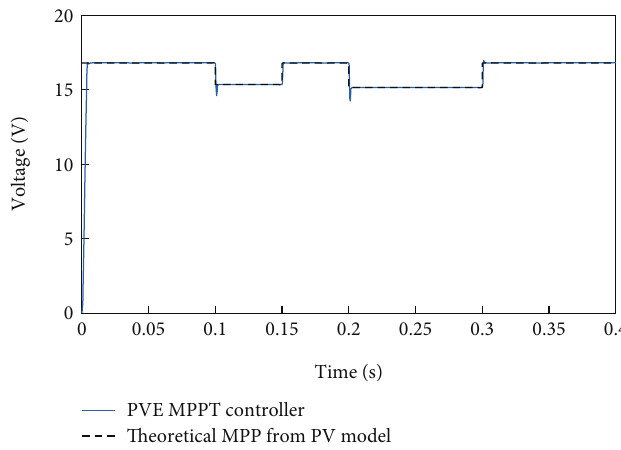
Figure 24: Voltage of the PVE system with MPPT control under fast-changing environmental conditions.